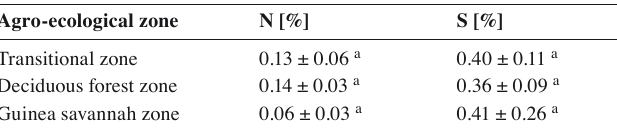
Tab. 4: Mineral composition of soils collected from the three agro-ecological zones.